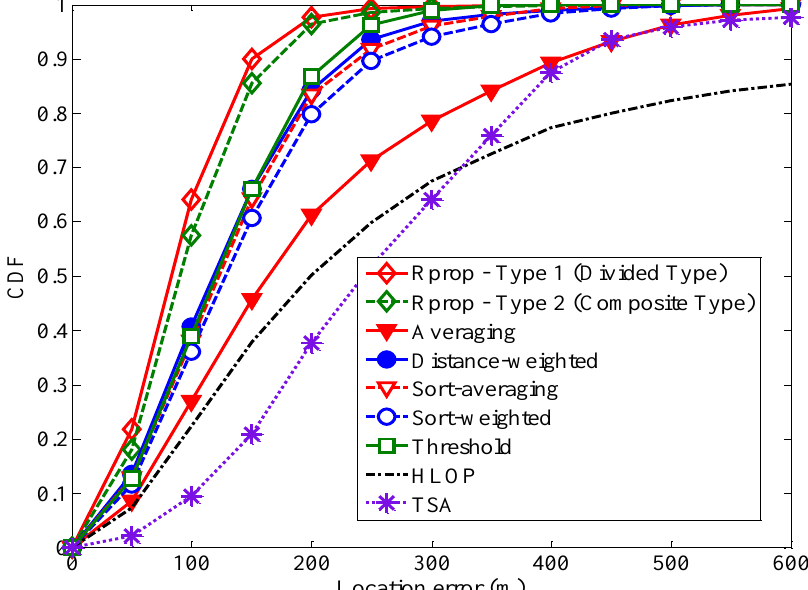
Figure 8. Comparison of error CDFs when NLOS errors are modeled as the upper